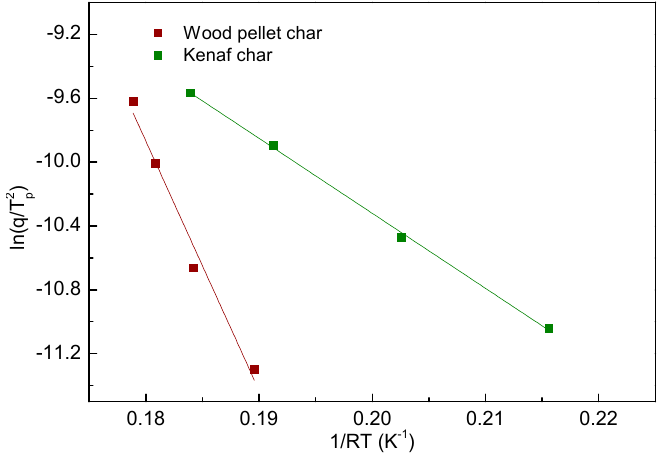
Figure 8. Kissinger plot of the TG analysis results.